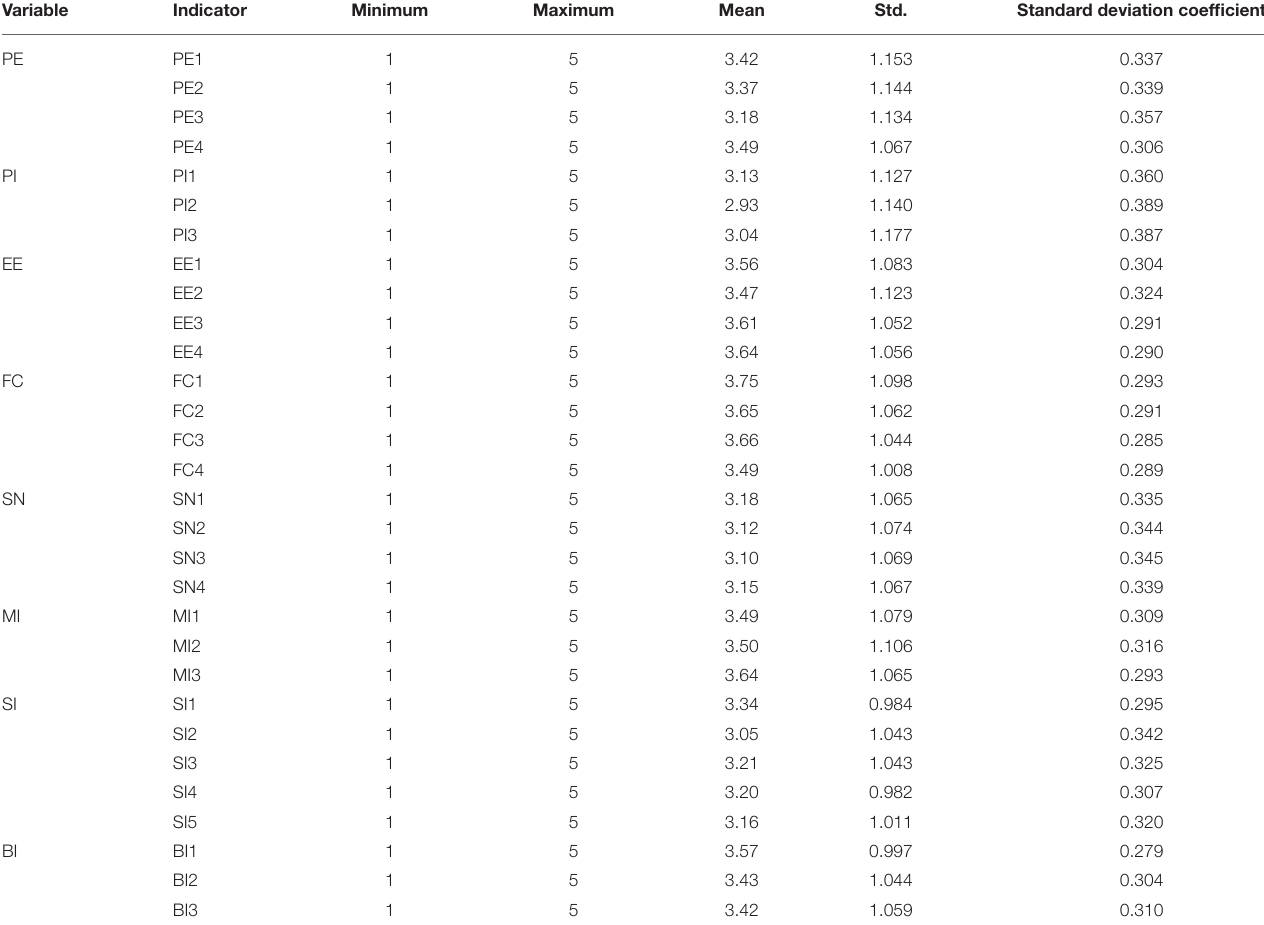
TABLE 3 | Summary statistics.